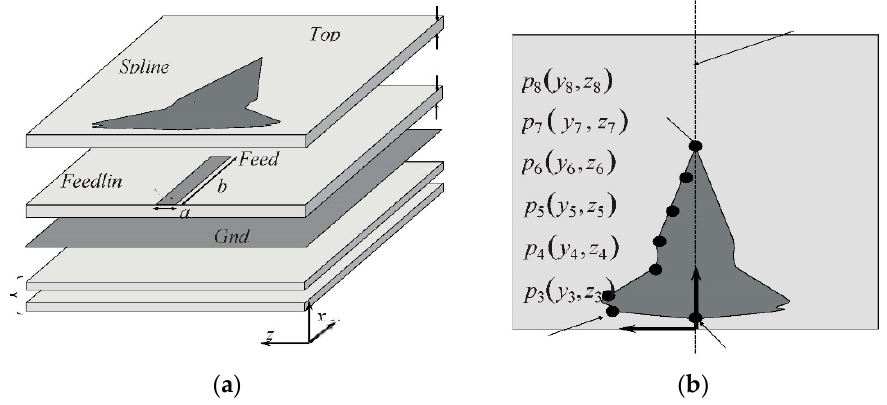
Figure 5. Geometry of the HDI—based filtering 5G patch radiator [35] ( a ) 3D and ( b ) top views.